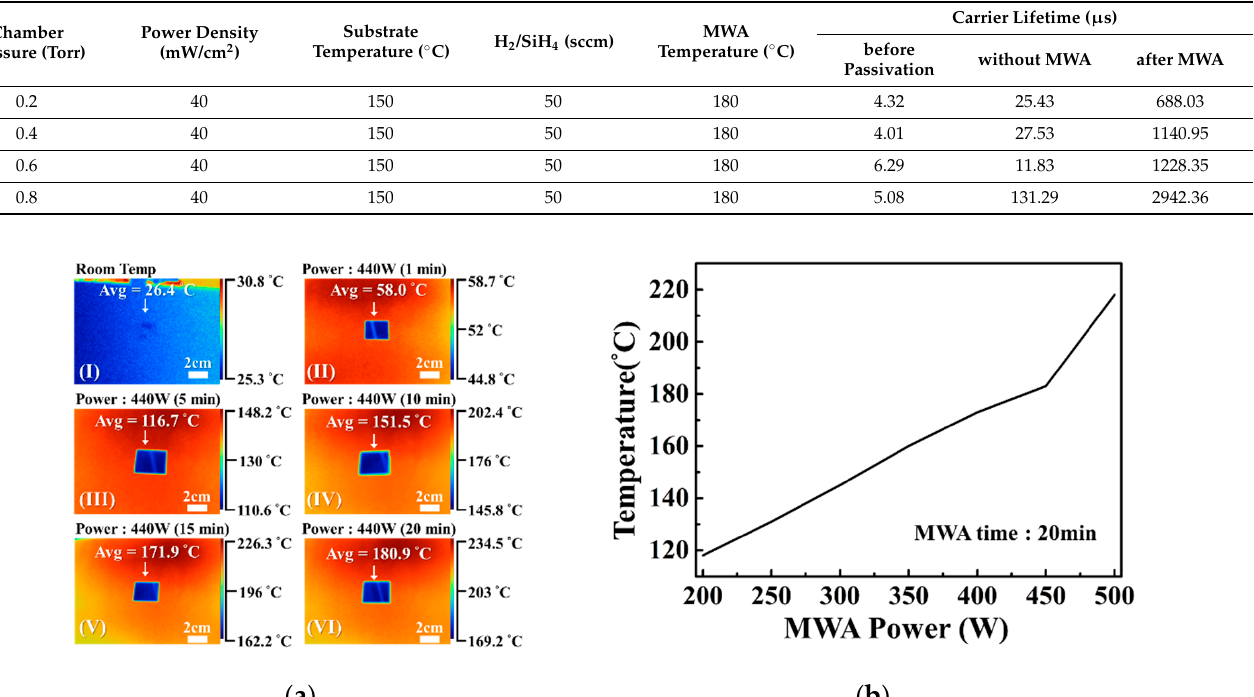
Figure 4. ( a ) Thermal image and ( b ) surface temperature of the thin film through microwave annealing. Table 1. Properties of the deposited nc-Si:H mixed-phase thin films. Note: MWA = microwave annealing.